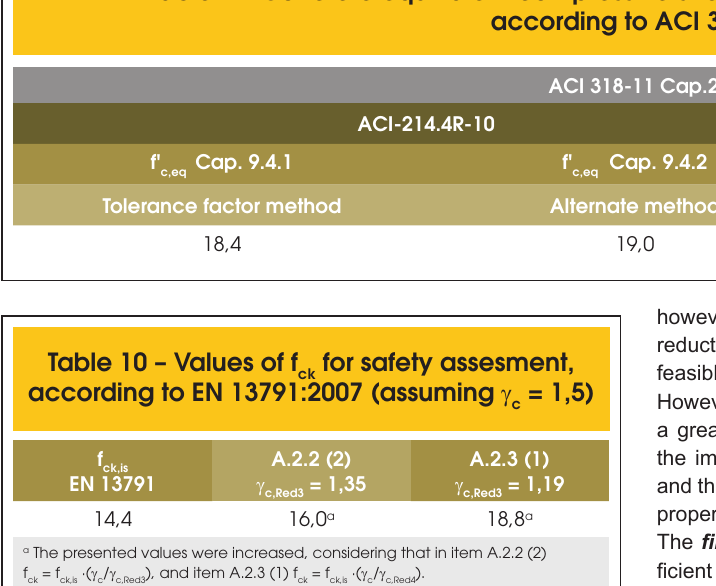
Table 9 – Concrete equivalent compressive strength values for safety assessment,